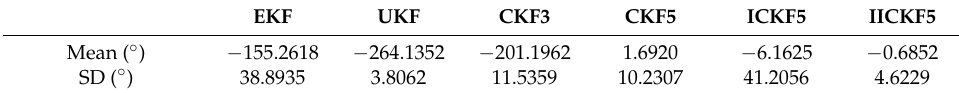
Table 3. Mean and Standard Deviation (SD) of azimuth misalignment errors ( ◦